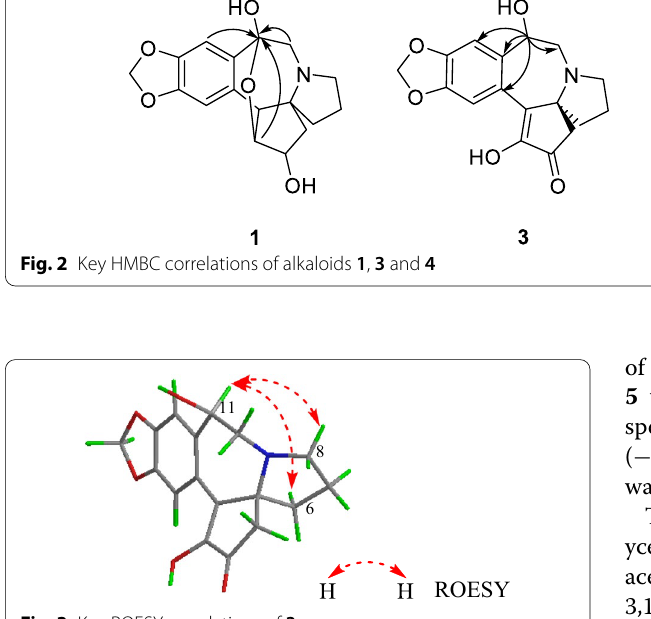
Fig. 3 Key ROESY correlations of 3